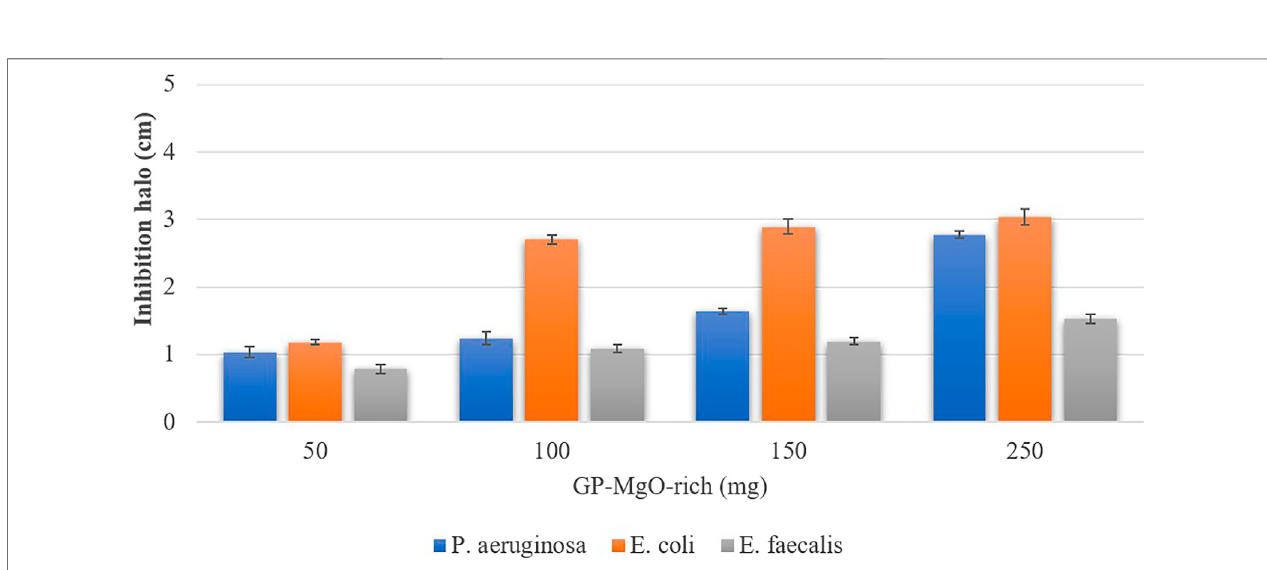
FIGURE 8 | Comparison of inhibition halo of P. aeruginosa , E. coli , E. faecalis in presence of increasing amounts of GP-MgO-rich sample.